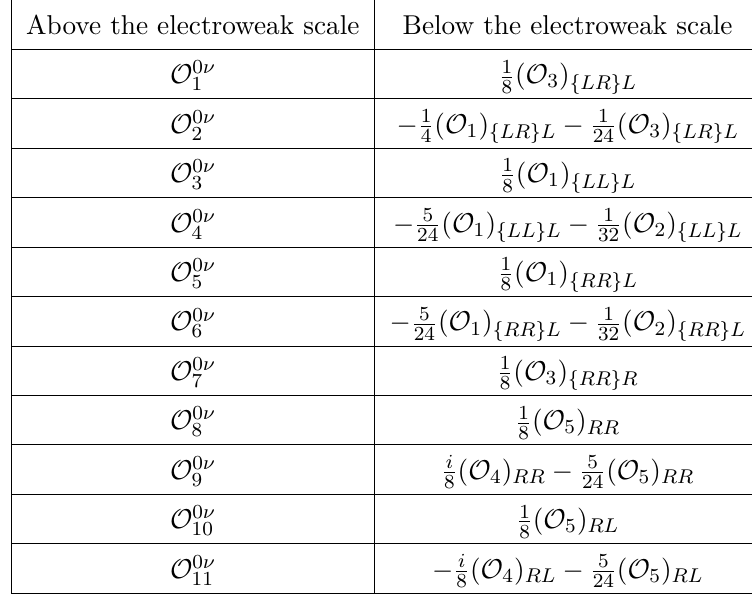
Table 5 . Matching between the 0 νββ decay operators above the electroweak scale and those below the electroweak